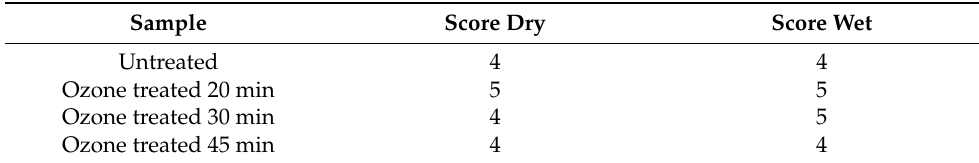
Table 5. Polyester fabric friction fastness score of